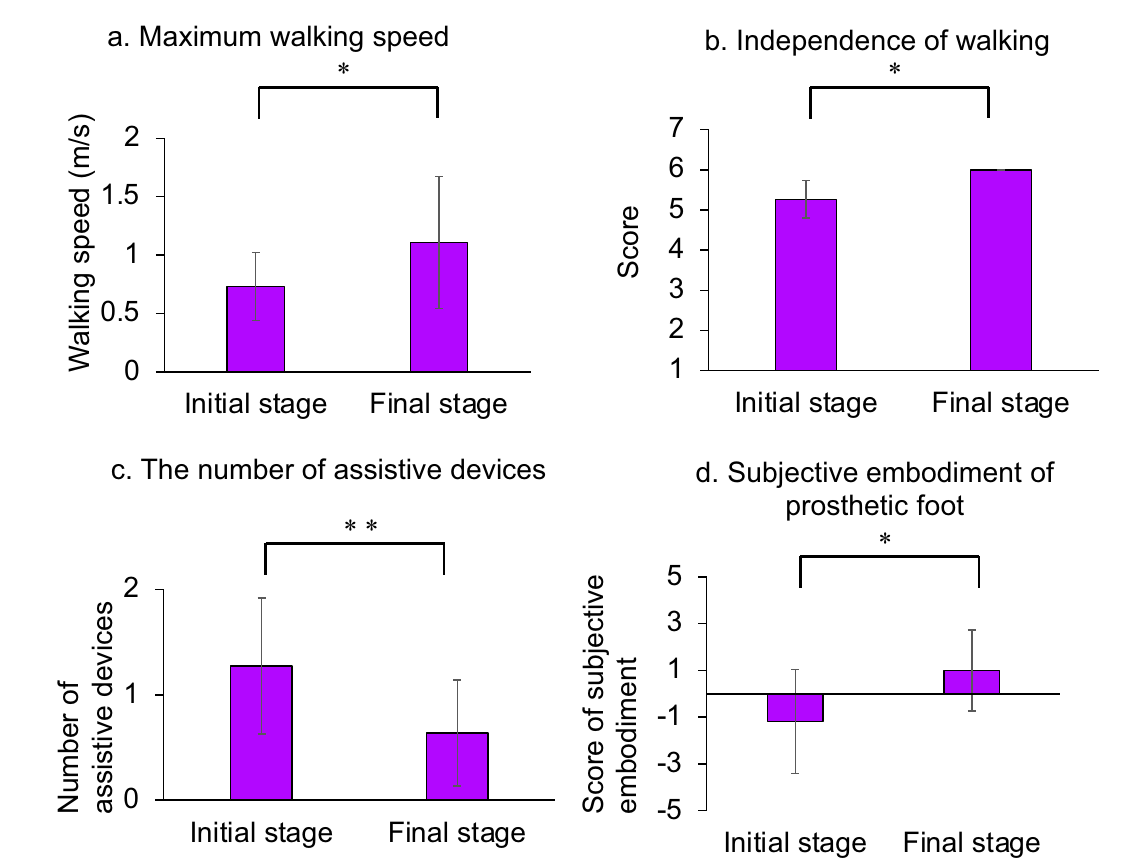
Figure 5. Comparison of initial and final stages. Figure clarifying the change in walking speed, independence in walking, number of assistive devices, and subjective embodiment of the prosthetic foot from the initial stage to the final stage. From the initial phase to the final phase, walking speed increased ( a ), walking independence score increased ( b ), the number of assistive devices decreased ( c ), and the score of subjective embodiment increased ( d ). Error bars represent standard deviations. * p < 0.05, ** p <